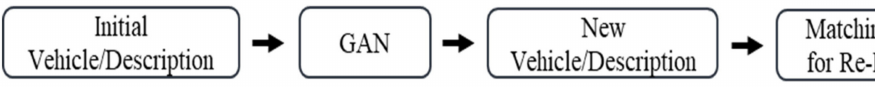
Figure 12. Vehicle re-id system based on GAN diagram.